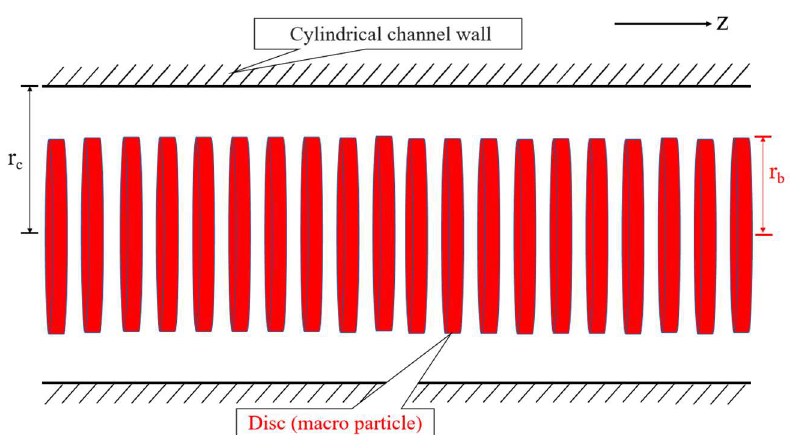
Figure 1. The macro particles of the Disc Model. The SCF is a statistical field generated by any two charged disks in the cylindrical channel.